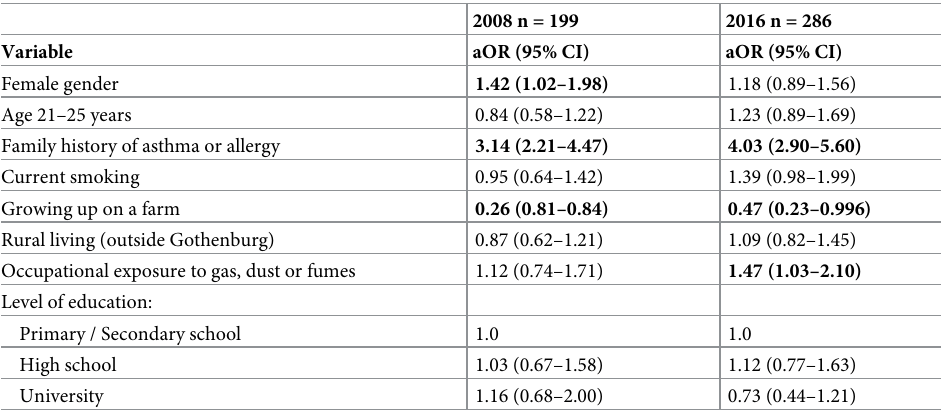
Table 2. Independent risk factors for current asthma in 2008 and